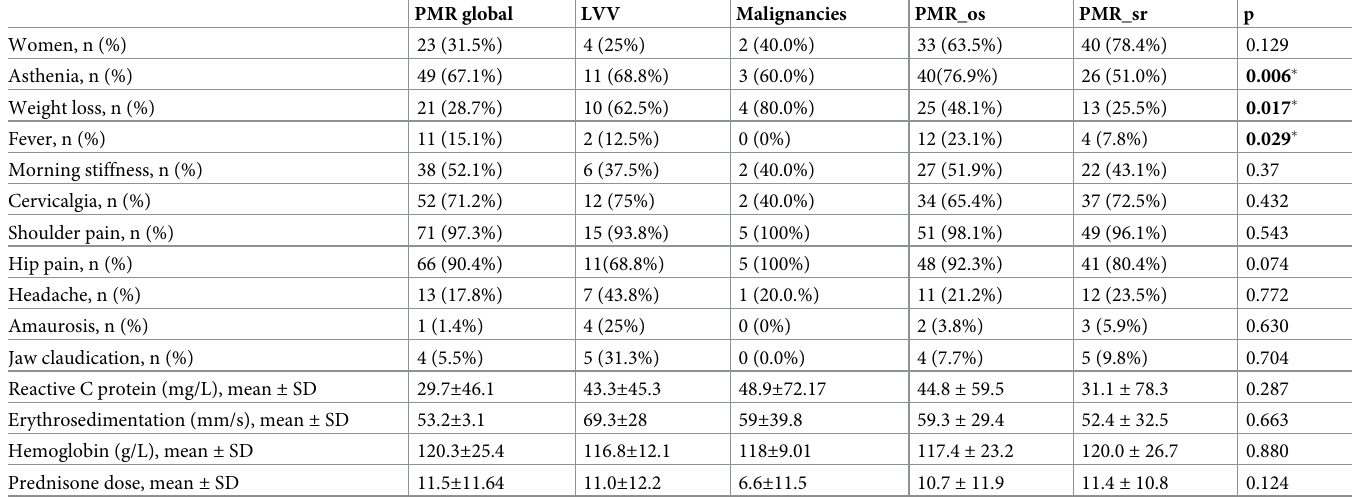
Table 4. Clinical features of patients: a) with onset PMR vs steroid resistant PMR b) with the final diagnosis of PMR, LVV or malignancy.